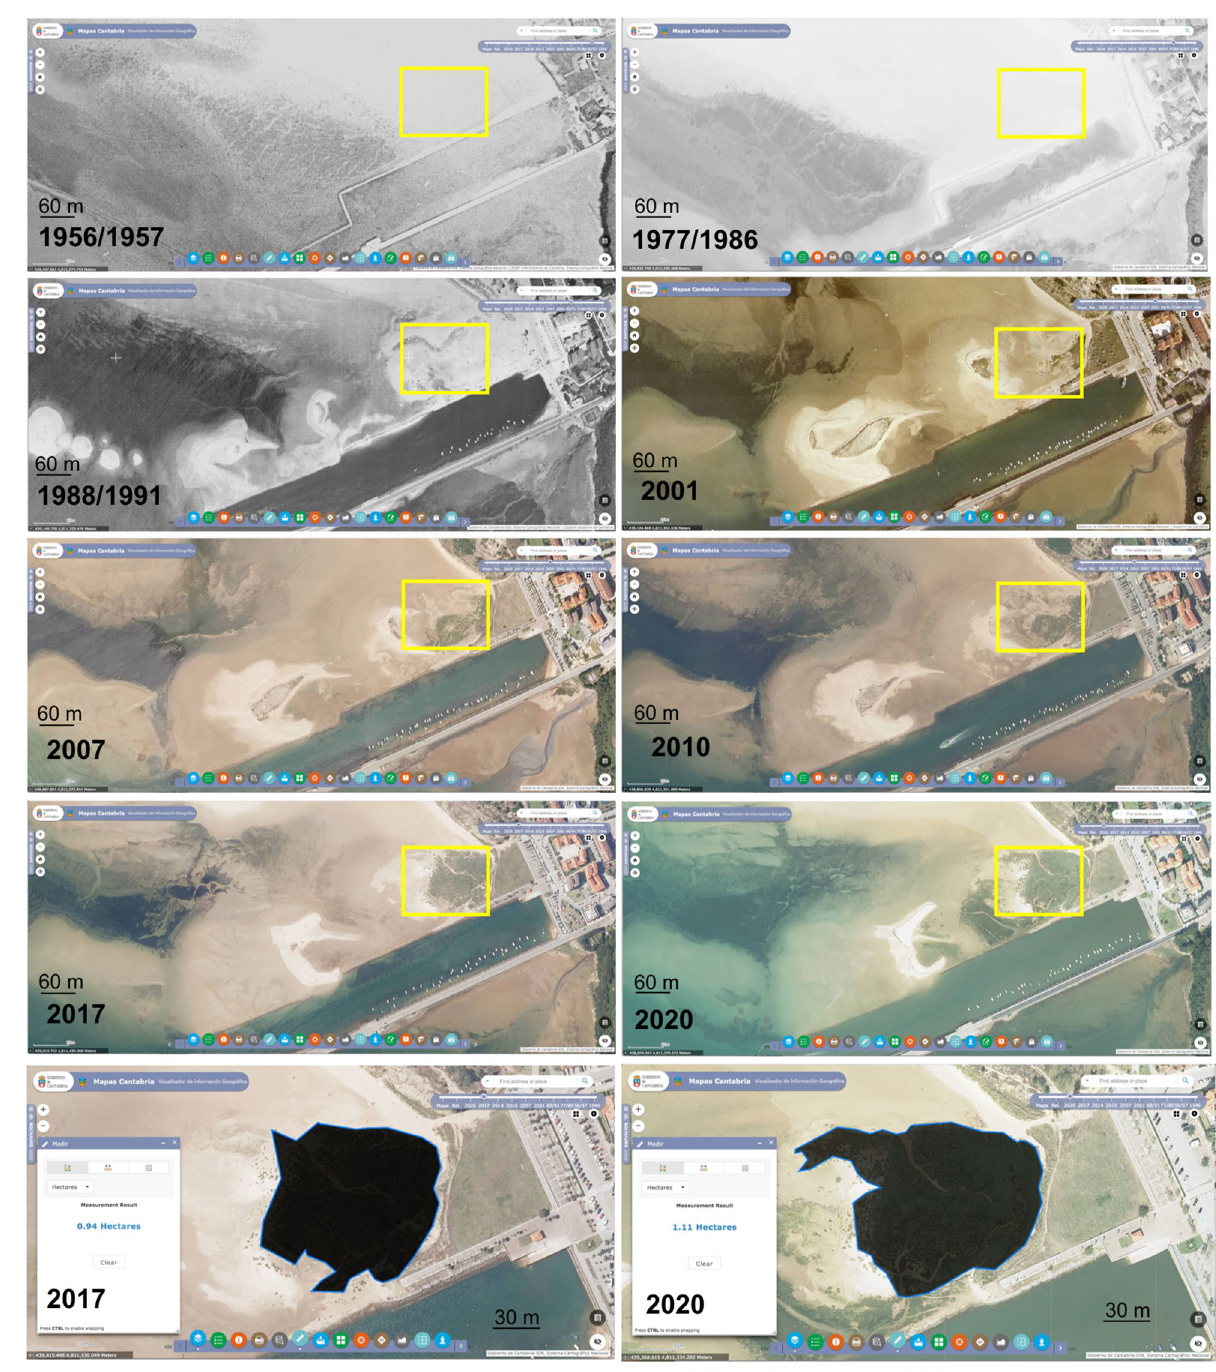
Figure 2. Old aerial photographs of the sampling area extracted from https:// mapas. canta bria. es. No old aerial photograph is available for the year of sampling. The area occupied by the high marsh community at the time of sampling (year 2019) is estimated by measuring, through the measuring tool available in https:// mapas. canta bria. es, the surface area occupied in 2017 and